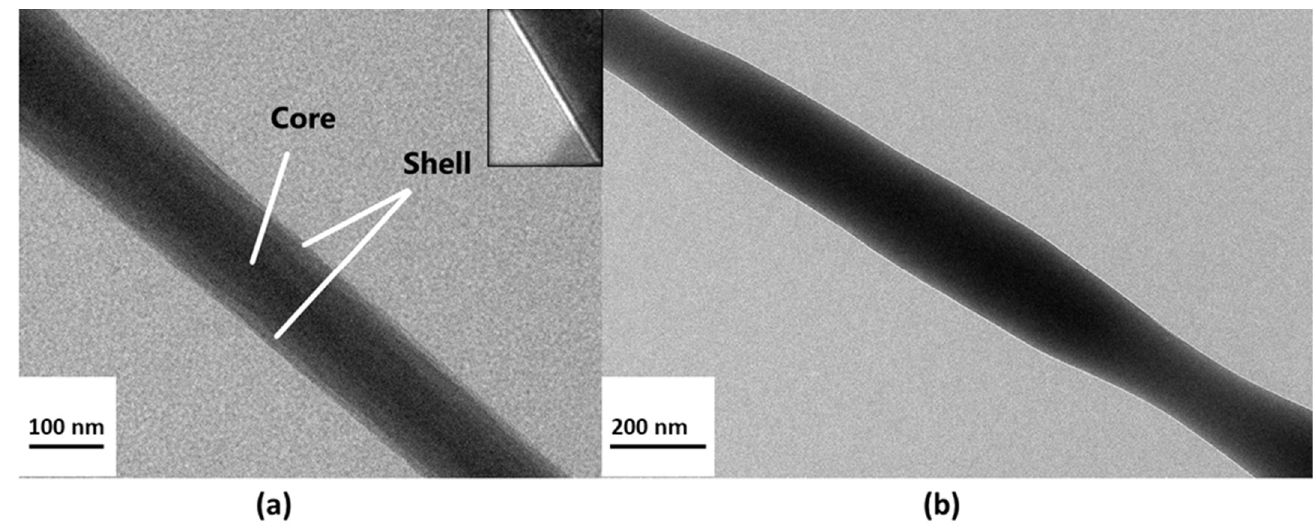
Figure 4. TEM images of: ( a ) core-shell fibers and ( b ) Gly crystals within core-shell fiber.